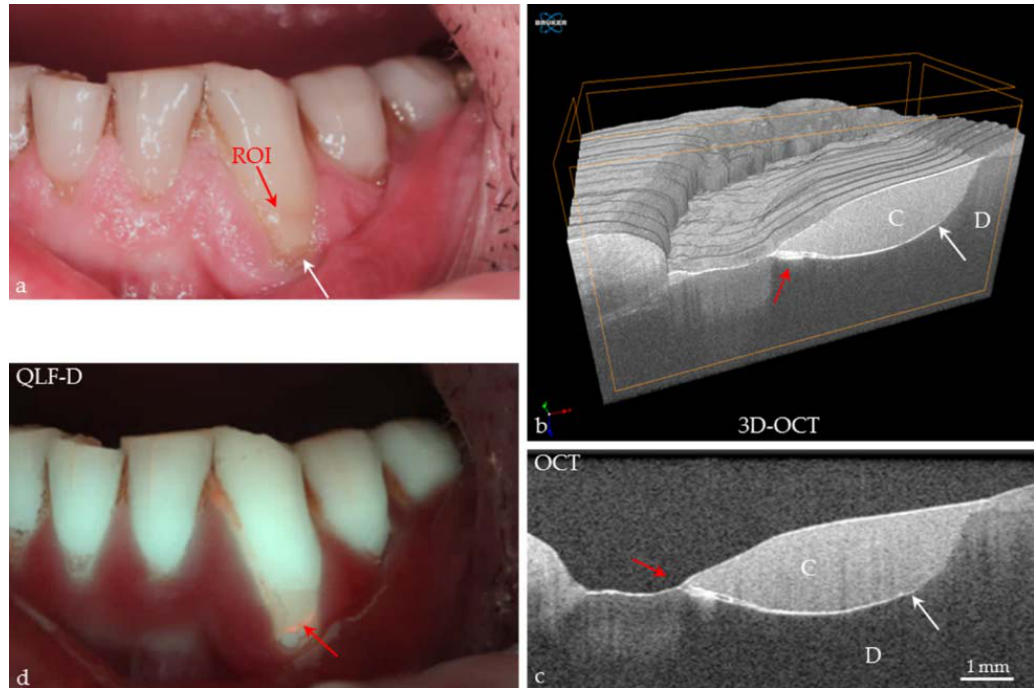
Figure 12. Canine tooth in vivo. ( a ) A cervical composite restoration (C) shows a margin discoloration (white arrow); ( b , c ) In the 3D and 2D OCT images, a margin gap with ingress of material is detected (red arrows). At dentin (D), an extensive interfacial gap has formed (white arrows); ( d ) Using quantitative light ‐ induced fluorescence the image showed red fluorescence (red arrow) at the cervical restoration margin indicating bacterial activity by porphyrin invasion into the gap. There are no signs of “secondary caries” at the restoration margin, but the stability of the situation requires observation over time (monitoring).